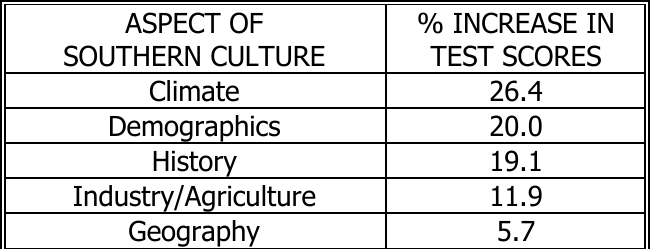
Increase in pre/post test scores grouped by aspects of southern culture ASPECT